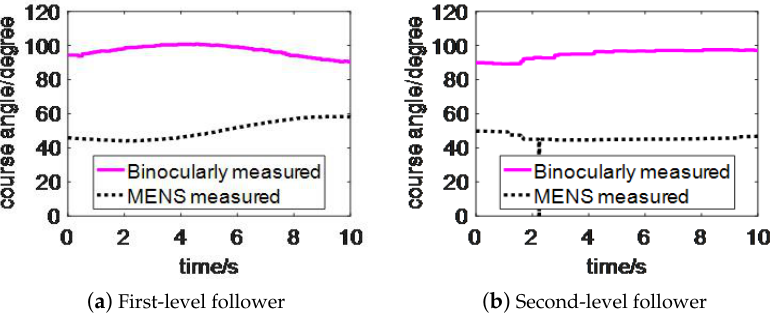
Figure 23. The yaw angle measured by the vision of first-level follower robot and the second-level follower robot compared with the self yaw angle measured by the MENS sensor over time.